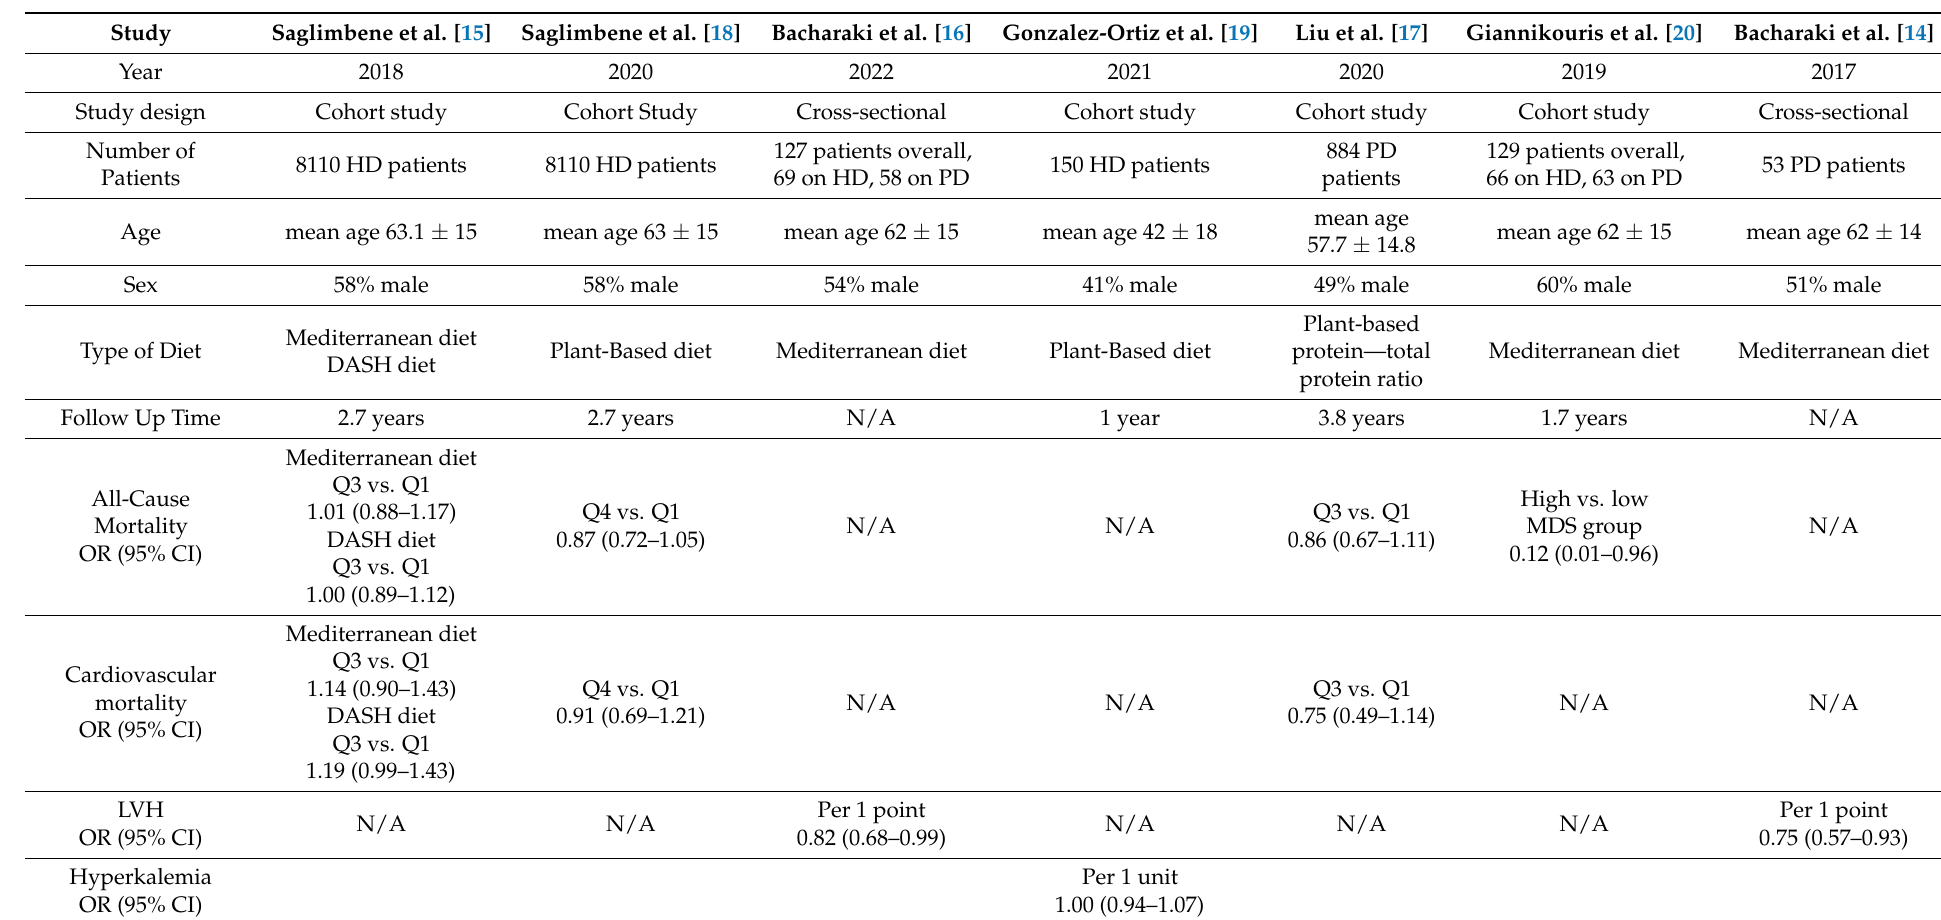
Table 1. Characteristics of included